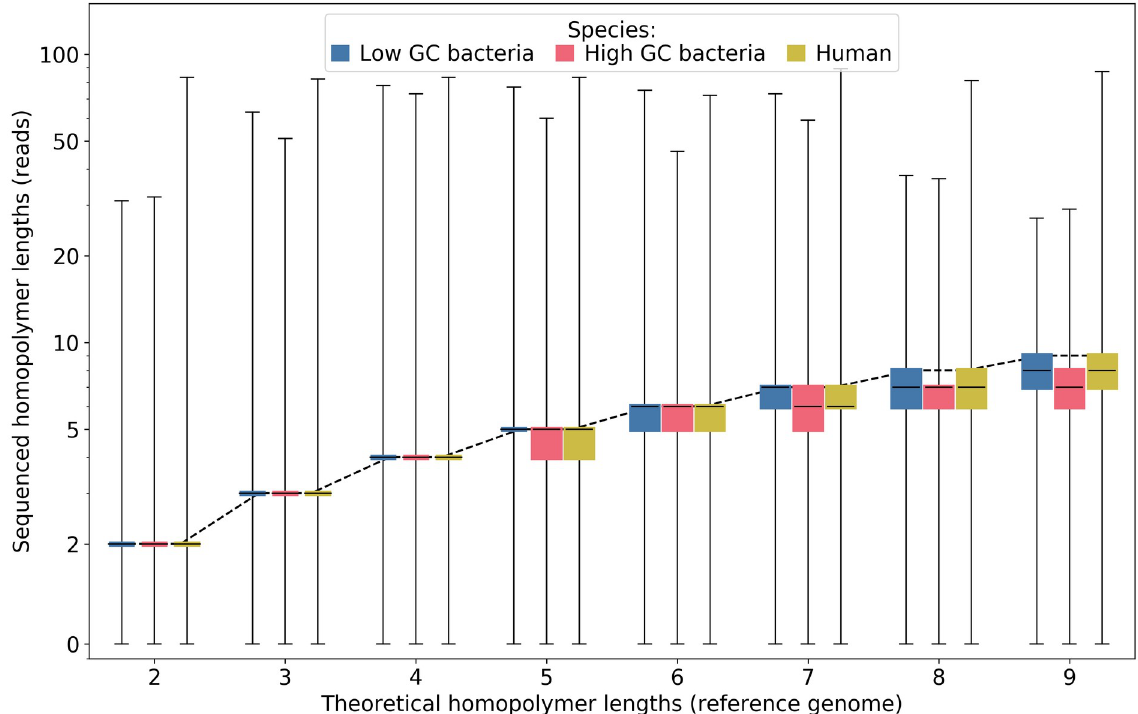
Fig 9. Errors in sequenced homopolymer lengths. The dotted line represents the expected length. The scale is semi-logarithmic.